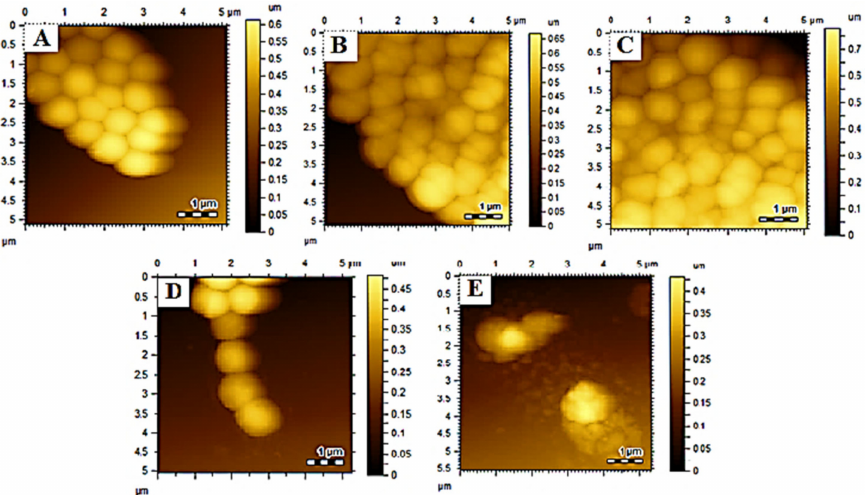
Figure 5. A Surface morphological analysis of S. aureus (sensitive) control ( A ), VCM treated ( B ), MOFs treated and ( C ), VCM − MOFs treated ( D ) and MNS − VCM − MOFs treated ( E ).